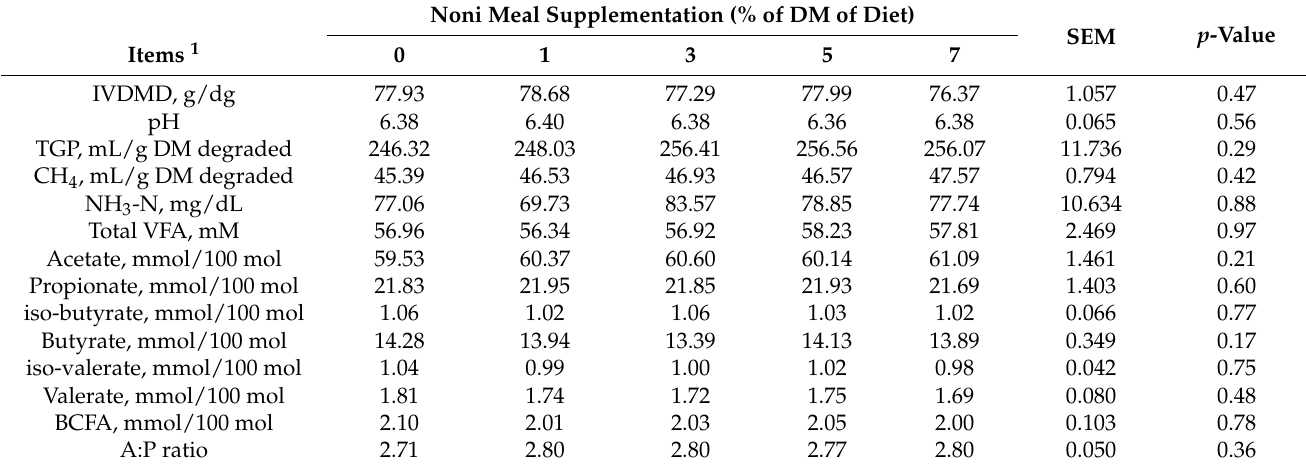
Table 4. Effect of noni meal on rumen in vitro dry matter digestibility (IVDMD), pH, total gas produc- tion (TGP), CH 4 , and NH 3 -N production, and volatile fatty acids (VFAs) profiles in 24 h incubation.